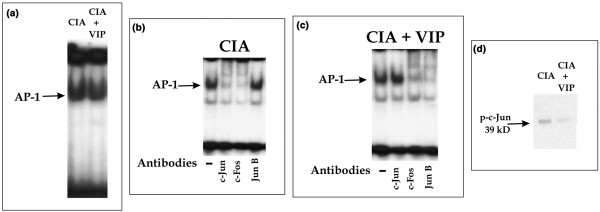
AP-1 binding and c-Jun activation in synovial cells from mice with collagen-induced arthritis (CIA) after vasoactive intestinal peptide (VIP) treatment. (a) EMSA results from nuclear extracts of synovial cells from CIA or VIP-treated CIA mice, using a radiolabeled oligonucleotide containing the AP-1 consensus binding site. (b) Supershift assay on nuclear extracts of CIA mice using anti-c-Jun, anti-c-Fos or anti-Jun B. (c) Supershift assay on nuclear extracts of VIP-treated CIA mice using anti-c-Jun, anti-c-Fos or anti-Jun B. (d) Western blot analysis showing immunoreactive phosphorylated c-Jun (39 kDa) in cytoplasmic fractions of synovial cells from CIA and VIP-treated CIA mice. A representative experiment of three is shown.